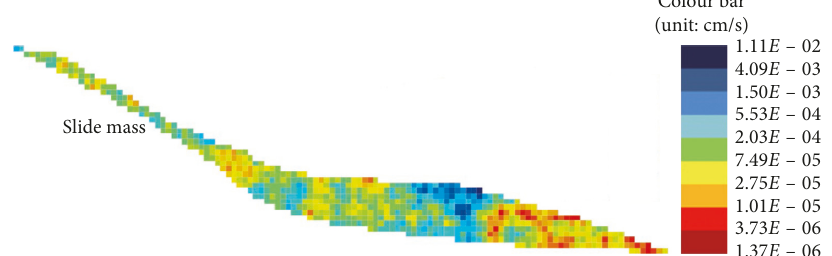
Figure 7: Estimated K s value of the slide mass based on the ordinary Kriging interpolation method.